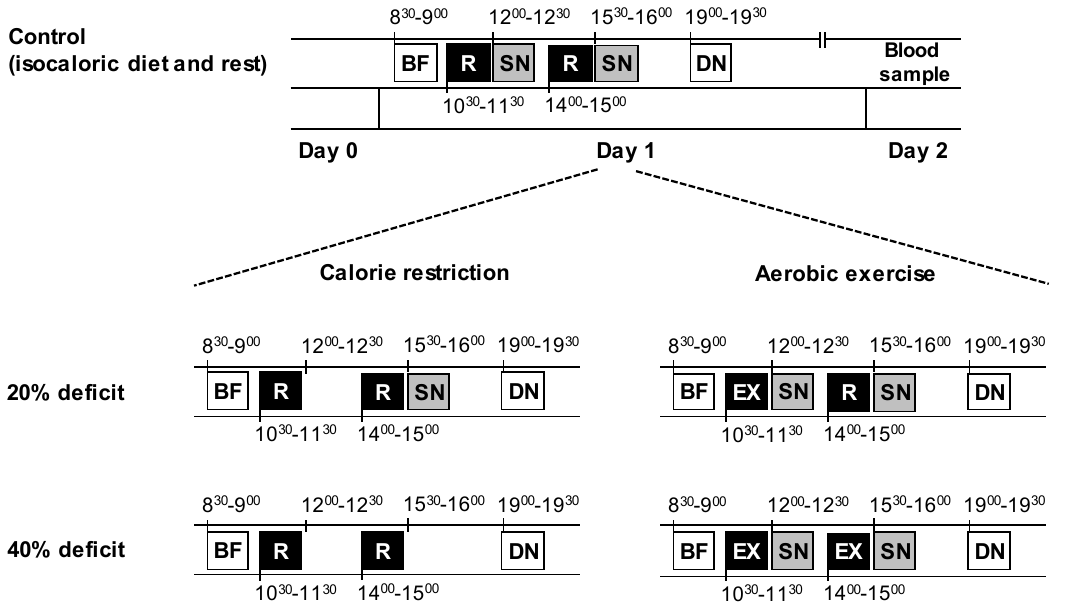
Figure 1. Experimental protocol. On day 1, subjects in both groups and all trials consumed an identical breakfast (BF) and dinner (DN), which provided 20% and 40% of the calories required for weight maintenance, respectively. Two snacks (SN), one in the morning and one in the afternoon, provided the remaining energy needed for weight maintenance (20% of calories each). In the diet group, subjects either consumed both snacks (control), one snack (20% deficit), or no snacks (40% deficit), and rested (R) in the morning and afternoon of day 1. In the exercise group, subjects either rested (control) or performed one bout (20% deficit) or two bouts (40% deficit) of aerobic exercise (EX), at approximately the same times of day as the corresponding resting periods in the diet group. After dinner, subjects fasted overnight and blood samples were obtained the next morning.